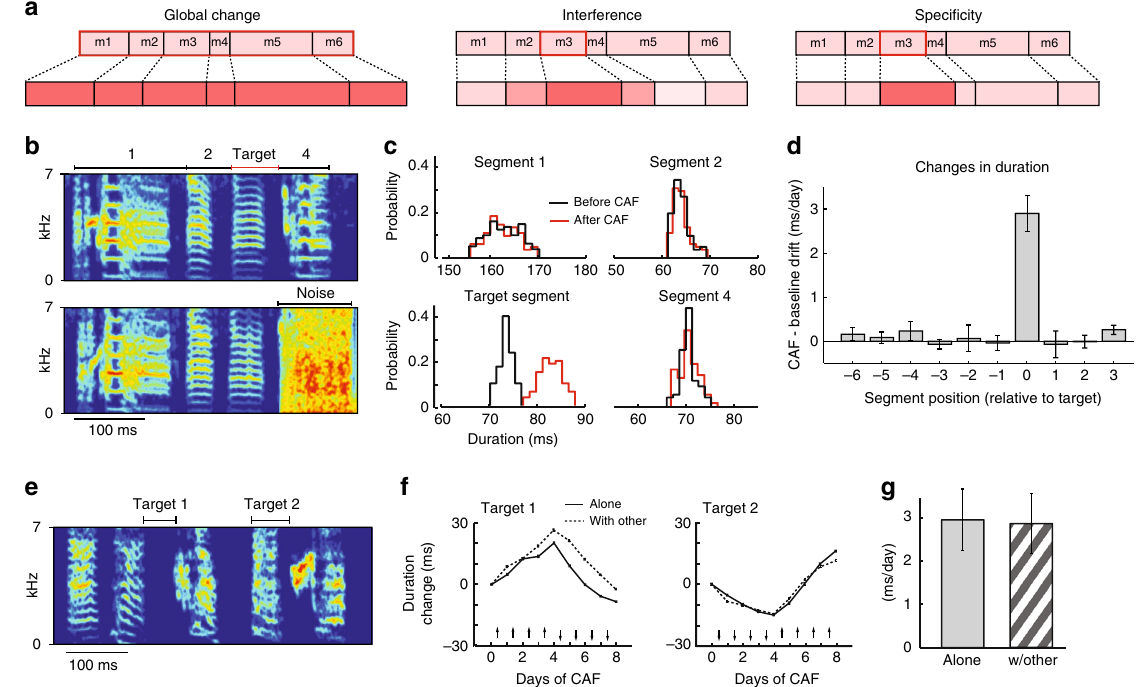
Fig. 1 Flexible modi fi cation of motor timing in songbirds. a Schematic showing different ways in which the temporal structure of a motor sequence (encompassing motor segments m1 – m6) can change. (Left) Global change — duration of all segments change together. (Middle) Interference — modi fi cations to the duration of one segment (m3, red box) interferes with (i.e., changes) the duration of other segments. (Right) Speci fi city — each segment can change independently of others. b (Top) Spectrogram of a zebra fi nch song, divided into four segments. One of these ( ‘ target ’ ) was marked for lengthening/shortening by delivering aversive noise bursts after the end of the target segment when its duration was below/above a threshold (Bottom, see Methods). c Duration distributions for the segments in b when the target segment was lengthened by our CAF paradigm. d Summary statistics (mean ± SEM) of the daily changes to the duration of target and non-target segments ( N = 18 targeted segments and n = 120 non-targeted segments in 18 birds). Changes in target intervals differed signi fi cantly from zero ( p = 1.6 × 10 − 6 , one-sample t -test), whereas non-targets did not (0.24 ≤ p ≤ 0.98, one-sample t - test). We used the same number of days of baseline (before CAF was started) as the number of days of CAF, which for each bird varied between 6 and 10 days. e Spectrogram of a song for which two segments were targeted for modi fi cation, either alone or in conjunction with each other. f Learning trajectories (mean ± SEM) from an example bird during CAF experiments designed to change the duration of the targets in e , either alone or together. Arrows denote the direction in which the duration of the targets were induced to change by the CAF paradigm. g Summary statistics (mean ± SEM) from our population of birds of the daily changes to the duration of targeted segments, as a function of whether they were targeted alone or together with another segment ( n = 12 segments in 6 birds, p = 0.54, paired-samples t -test; see